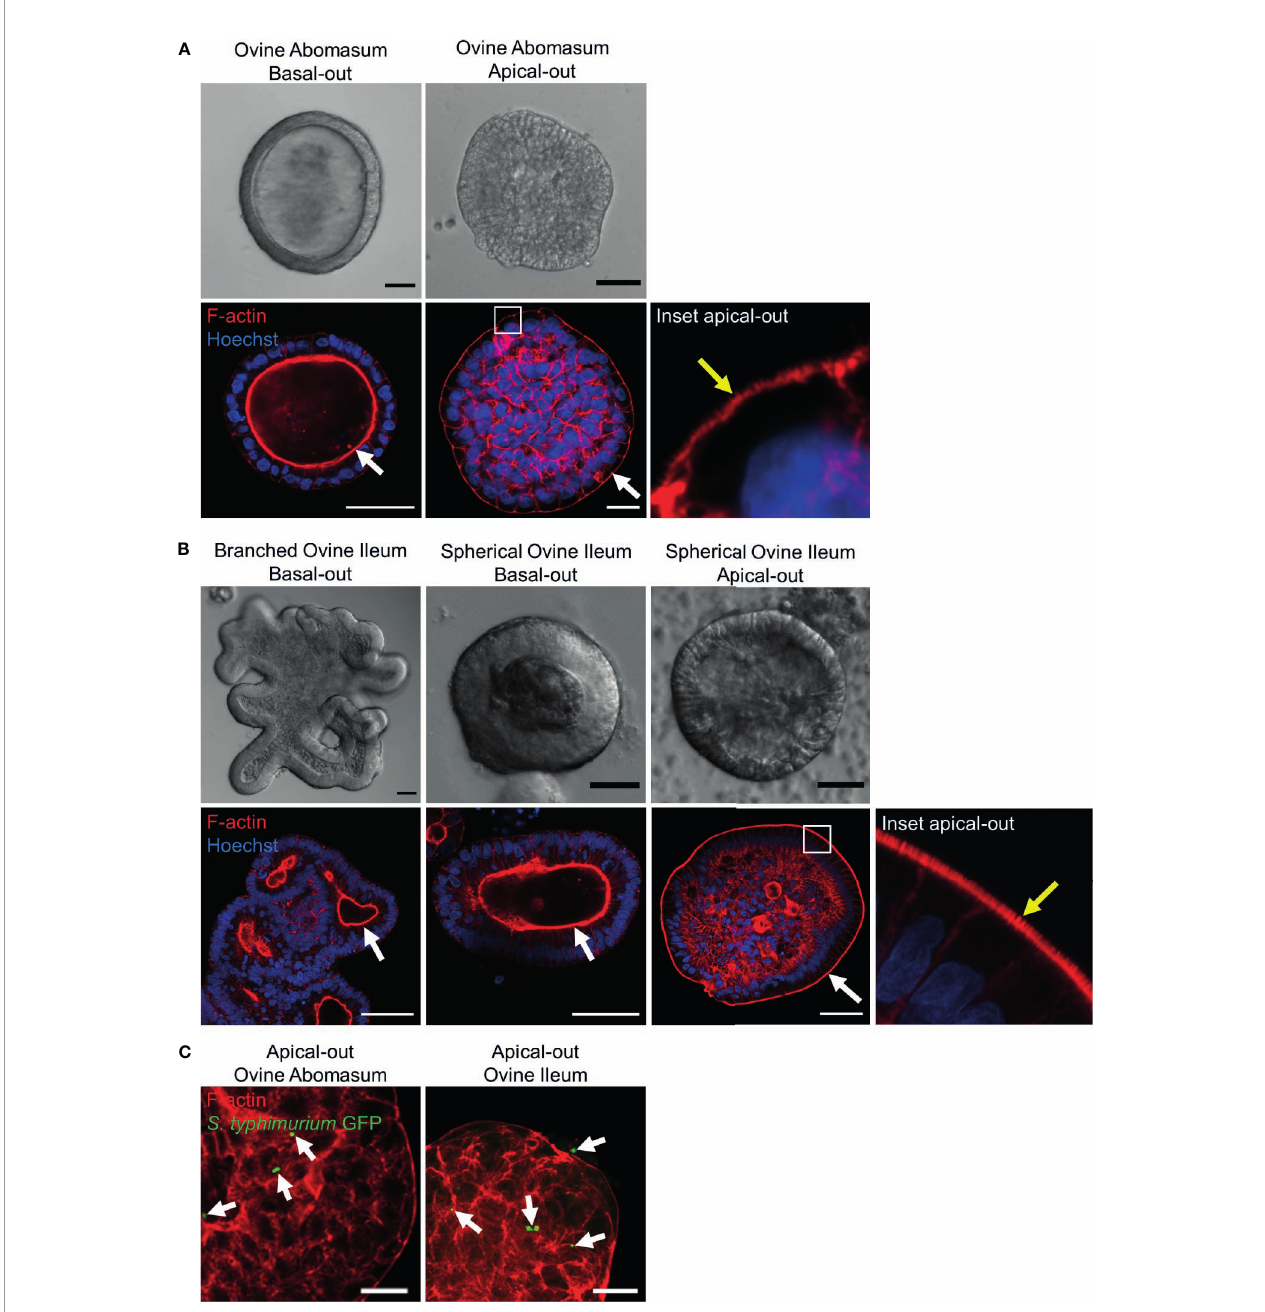
FIGURE 10 | Reverse polarisation of ovine gastric and intestinal organoids for modelling host-pathogen interactions across the apical surface. Basal-out and apical- out abomasum (A) and ileum (B) organoids imaged by differential interference contrast (top) and confocal immuno fl uorescence microscopy (bottom). White arrows indicate the F-actin-expressing brush border associated with the apical surface of the epithelia. Yellow arrow in the inset panel indicates microvilli at the externally located brush border in apical-out organoids. (C) Cross sections of apical-out abomasum and ileum organoids imaged by confocal microscopy. GFP-expressing Salmonella enterica Typhimrium (green), indicated by white arrows, are detectable on the surface of and within epithelial cells. F-actin (red) and Hoechst (blue). Scale bars = 10